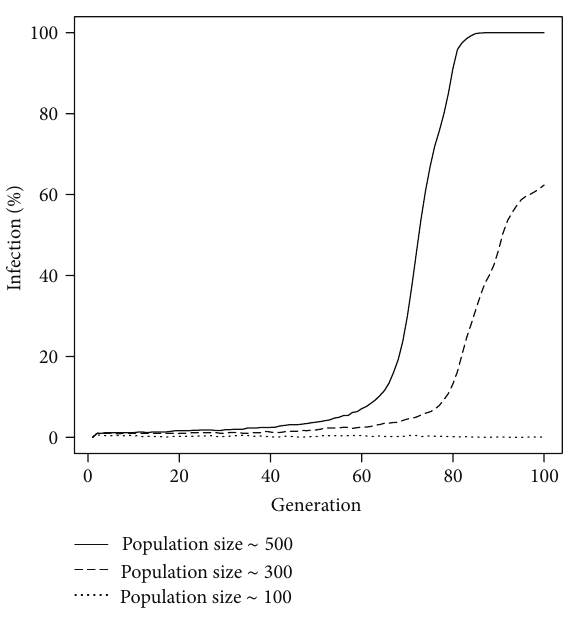
Figure 3: Effect of population size.